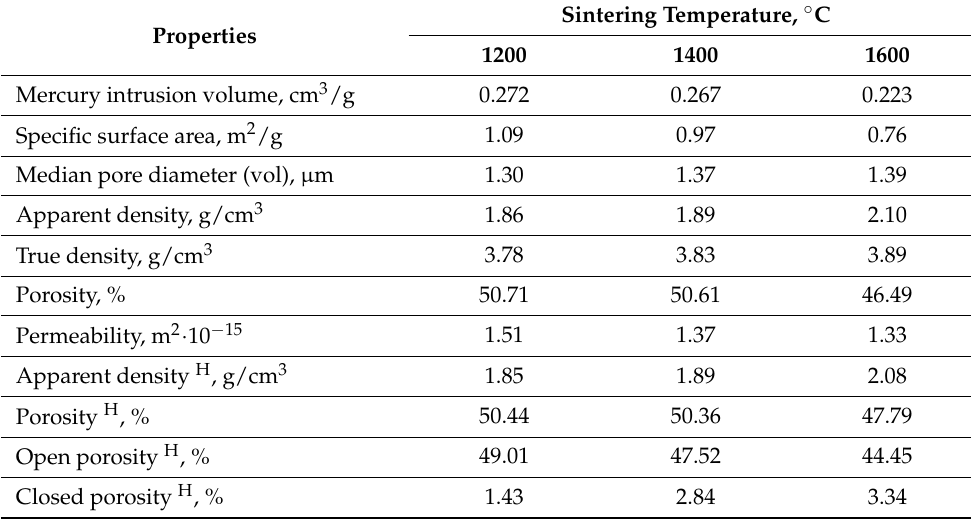
Table 1. The results of porosimetric and hydrostatic analyses of sintered ceramic skeletons in a temperature range from 1200 to 1600 ◦